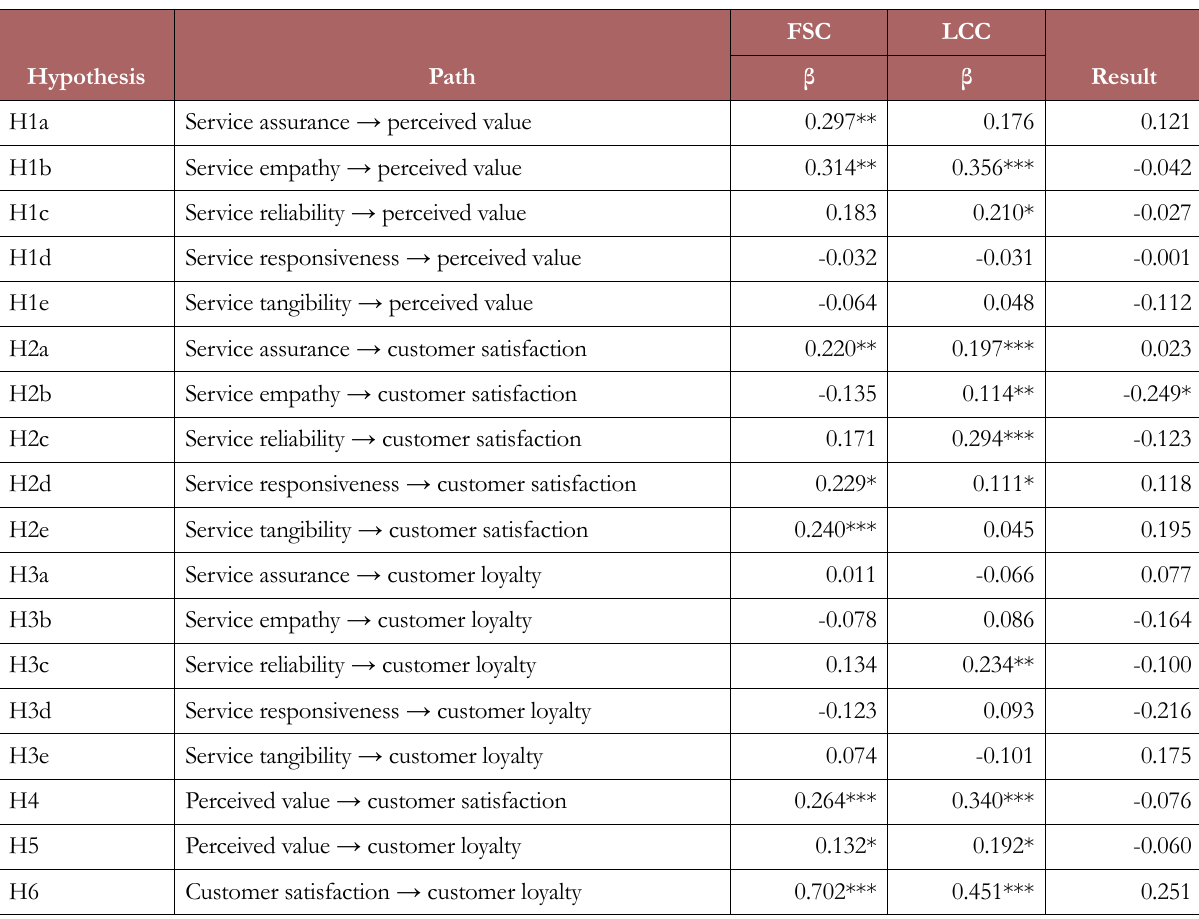
Table 6. Hypothesis test results for FSC and